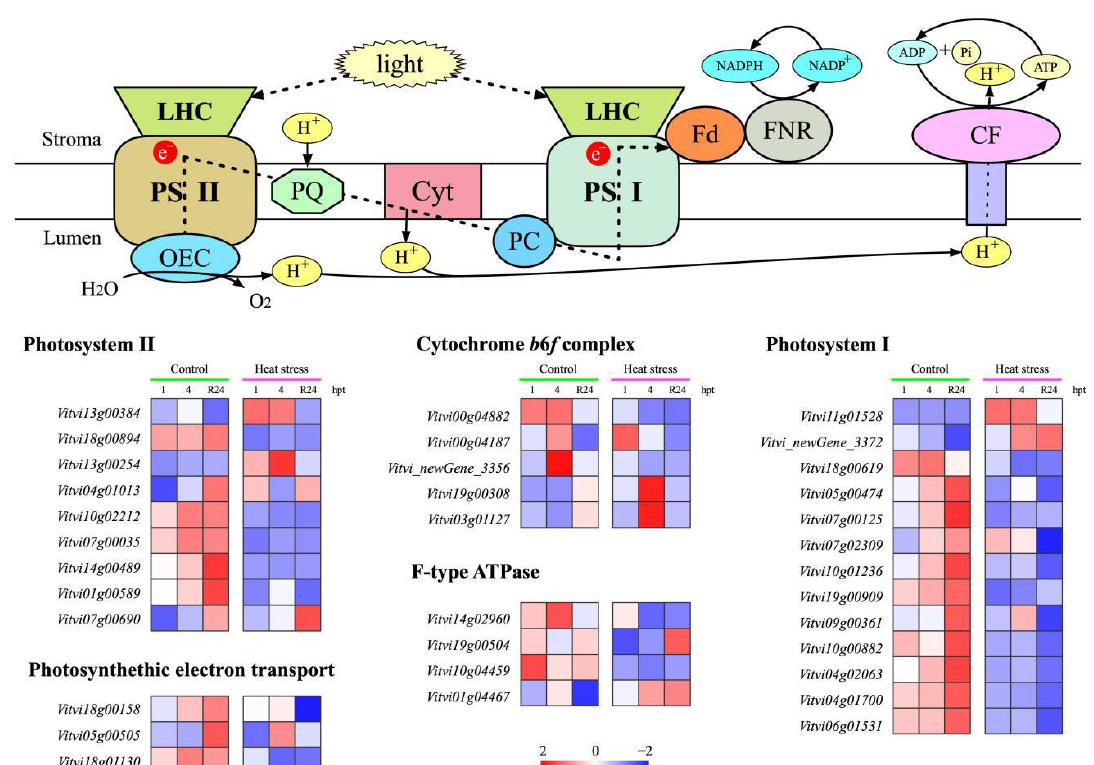
Figure 5. Transcriptomic profiles of DEGs involved in photosynthesis pathway following HS treat- ment and subsequent recovery. Different shades of red and blue express the average FPKM value (log2 transformed) of the gene in each sample, as illustrated in the legend.